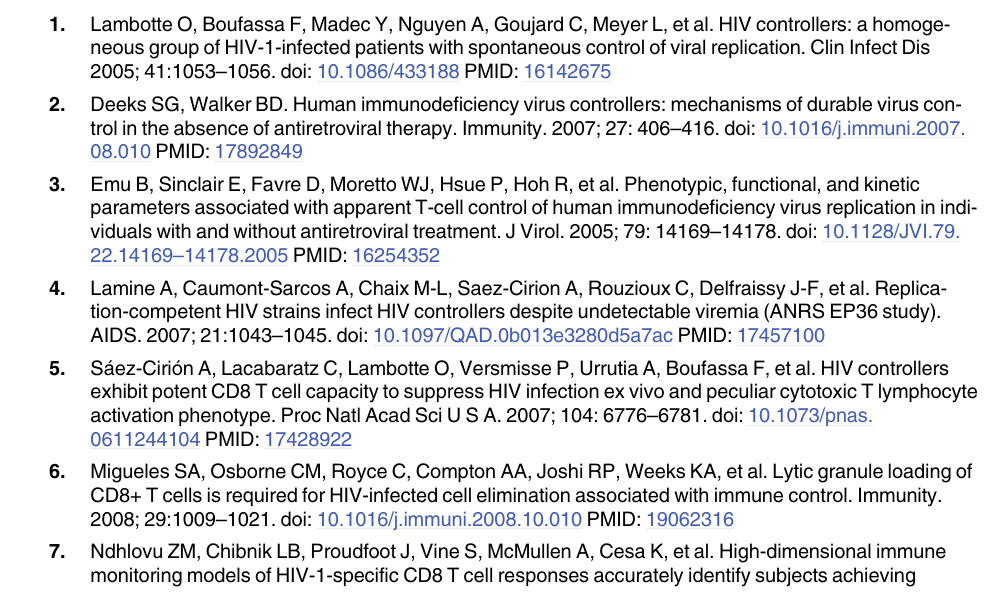
S1 Fig. Examples of immunologic progression (Fig A) and virologic progression (Fig B).